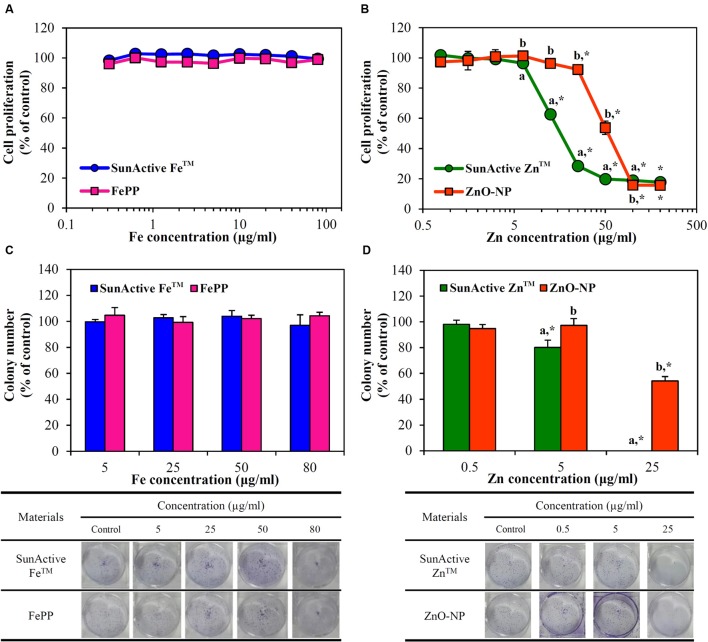
Short-term effect of
(A) SunActive FeTM and (B) SunActive ZnTM on cell proliferation of INT-407 cells after treatment for 24 h, measured by WST-1 assay. Long-term effect of (C) SunActive FeTM and (D) SunActive ZnTM on colony-forming ability of INT-407 cells incubated for 7 days. FePP and ZnO-NPs were used as counterpart materials for SunActive FeTM and SunActive ZnTM, respectively. Mean values with different letters (a,b) in the same concentrations indicate significant differences between SunActiveTM product and its counterpart material (p < 0.05). ∗ Indicates significant differences from the untreated controls (p < 0.05).